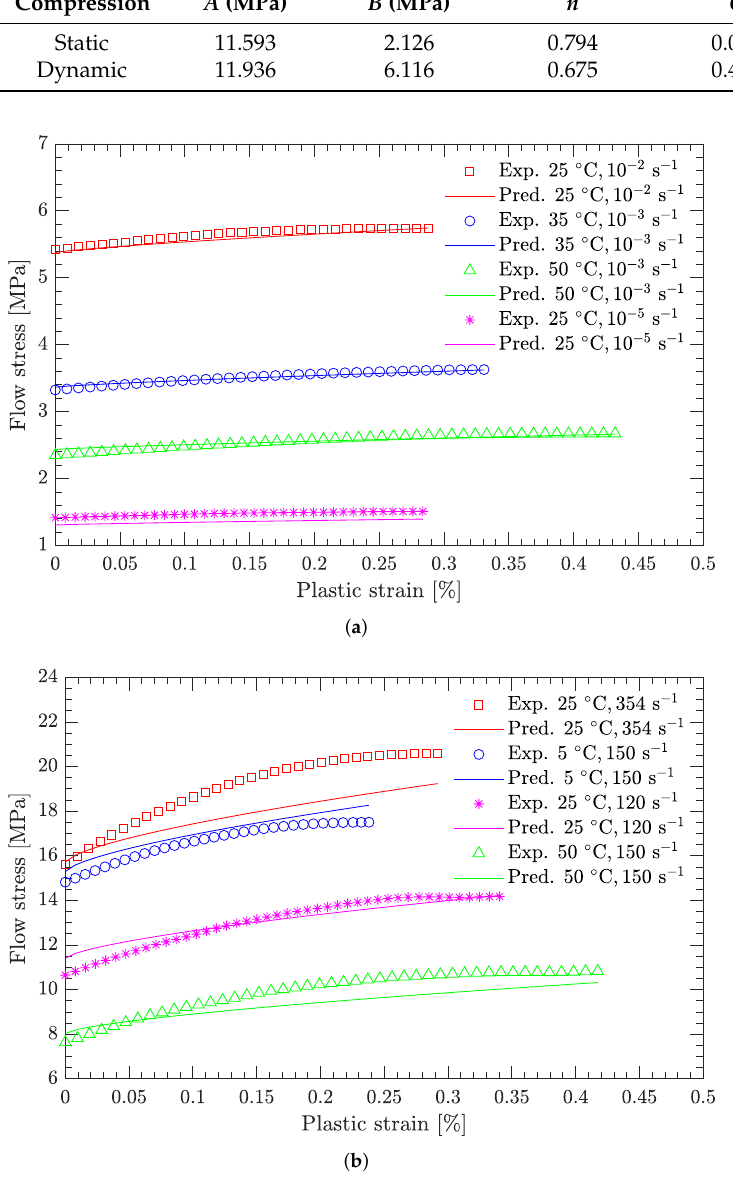
Figure 18. Effect of definition of yield point on the predicted flow stress. ( a ) Static compression; ( b ) dynamic